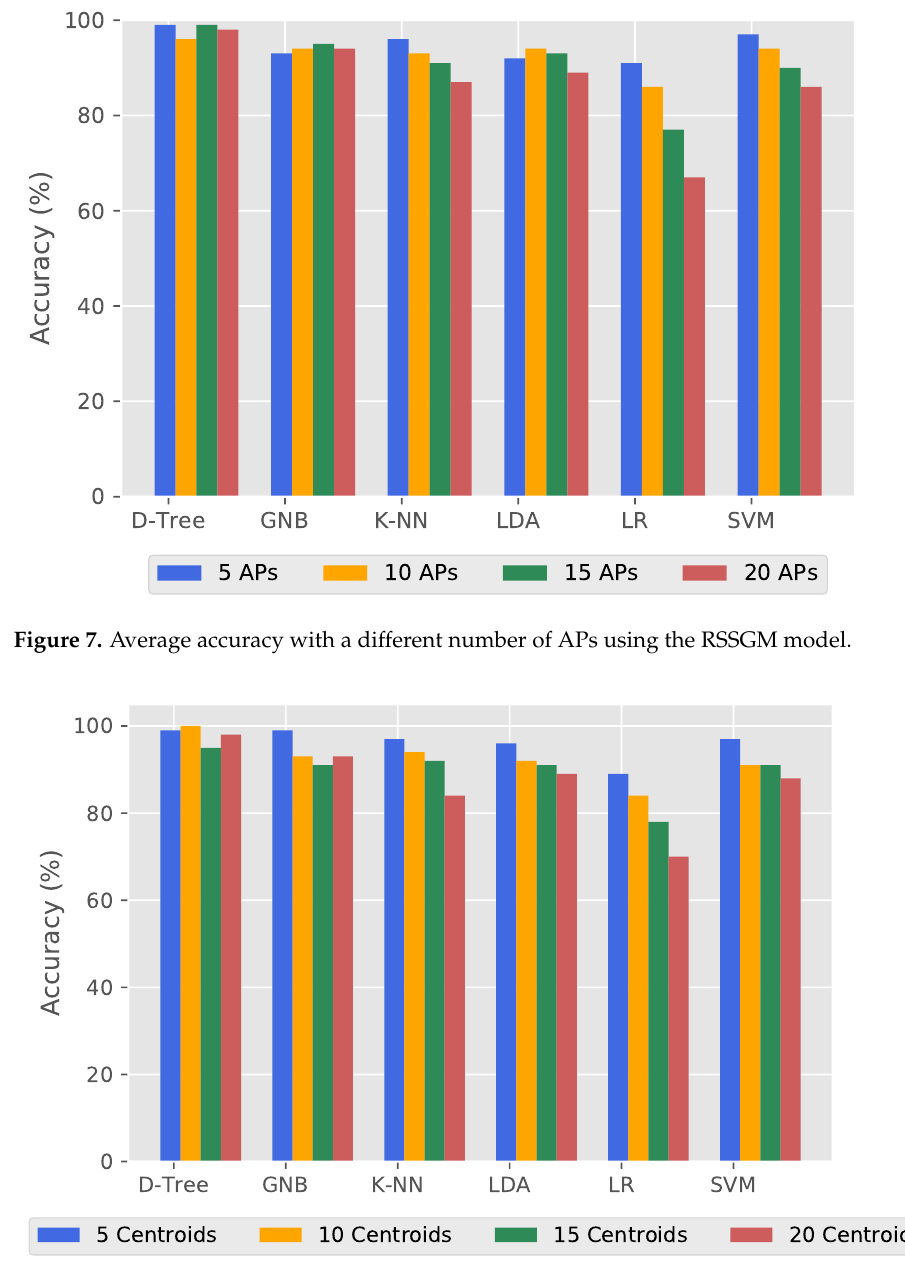
Figure 8. Average accuracy with a different number of centroids using the RSSGM